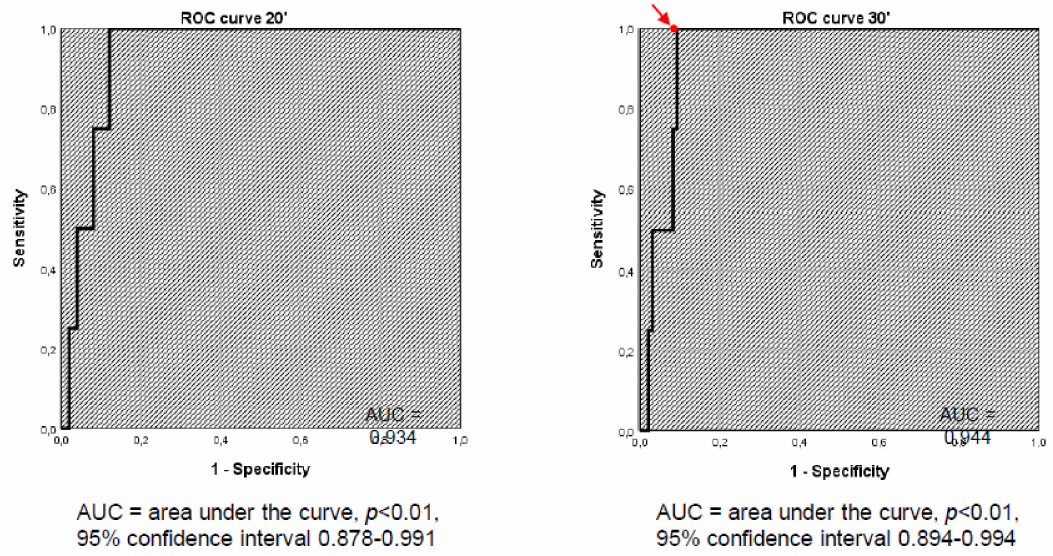
Figure 2. Receiver operating characteristic (ROC) curve of serum cortisol levels at 20 and 30 minutes after ACTH stimulation. Table 2 summarizes performances of 1 µ g ACTH stimulation for cut-o ff levels of 500 nmol / L and 401.5 nmol /